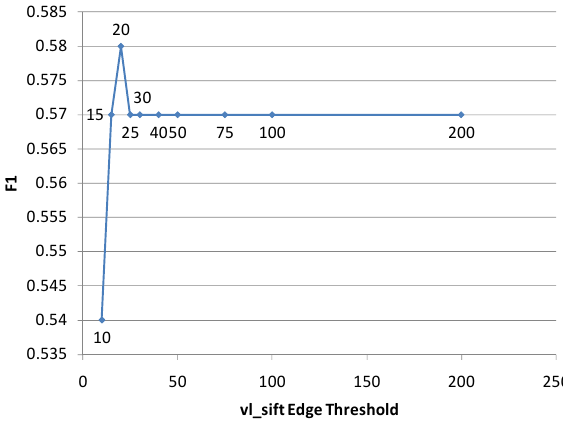
Figure 8. Experimental results for various values of vl_sift edge